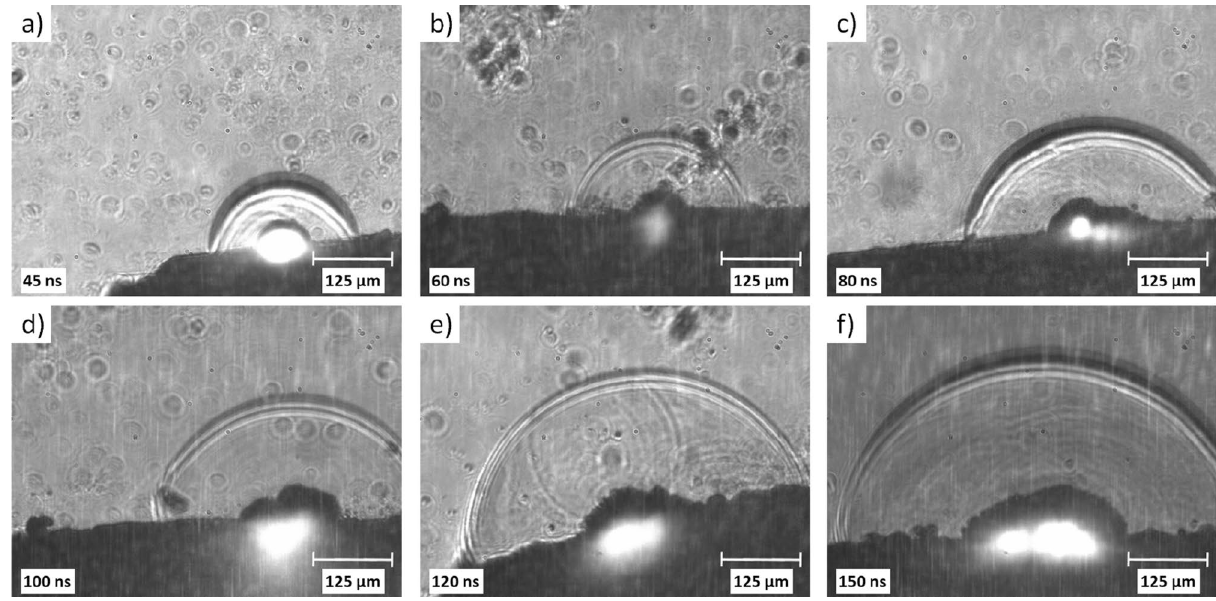
Figure 12. Fast photography images of pulsed laser ablation (λ = 1064 nm, F = 18 J/cm 2 ) of meloxicam in distilled water. (a)–(f) Formation and propagation of the wave front double-exposed at two moments with t = 8 ns time separation; (c)–(f) Generation and size changes of the cavitation bubble.